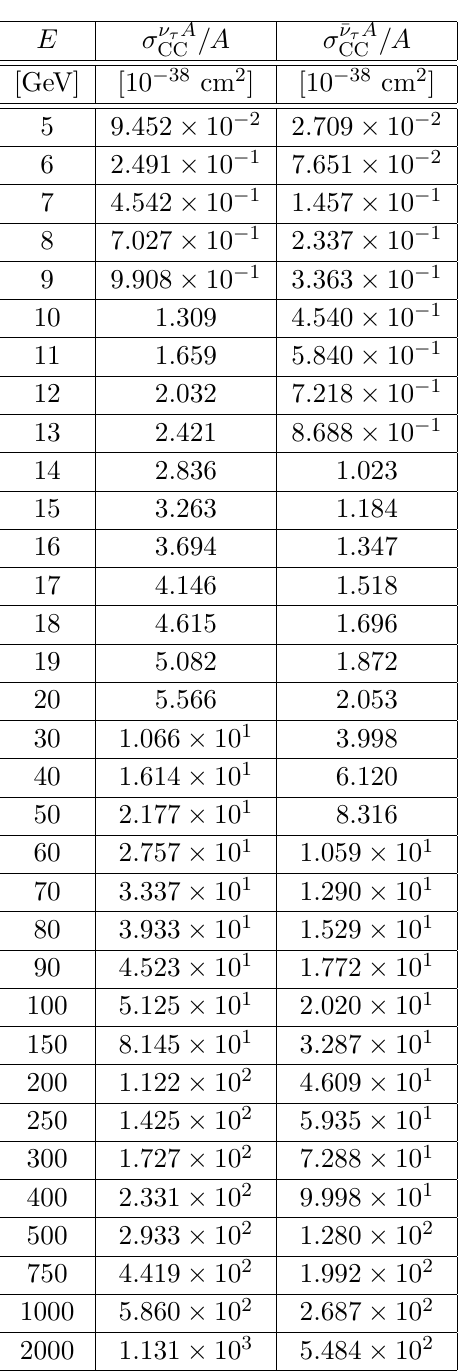
Table 12. The ν τ and ¯ ν τ charged current cross section per nucleon for interactions with tungsten, evaluated using the PROSA VFNS PDFs. Isospin symmetry is used for the neutron PDFs. Tables for incident tau neutrino and antineutrino energies between 5 GeV and 5 TeV are available as sup- plementary material attached to this